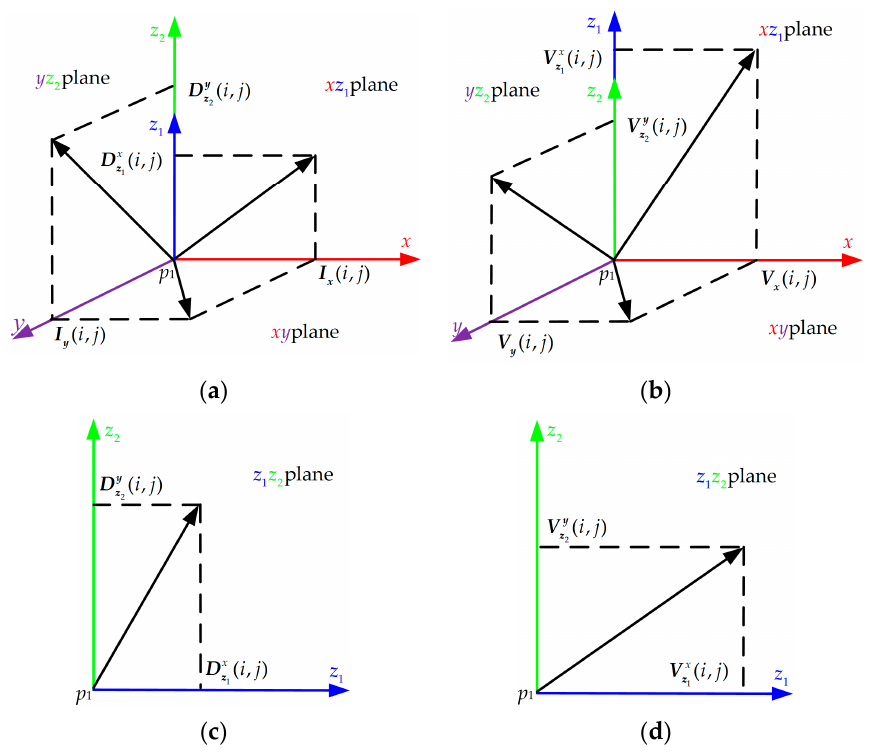
Figure 6. Extended gradient space and motion space. ( a ) 3D gradient space with xy , xz 1 and yz 2 planes; ( b ) 3D motion space with xy , xz 1 and yz 2 plane; ( c ) z 1 z 2 plane made of D x z ( i , j ) and V y z ( i , j ) . ( a , c ) form the extended gradient space; ( b , d ) form the extended motion